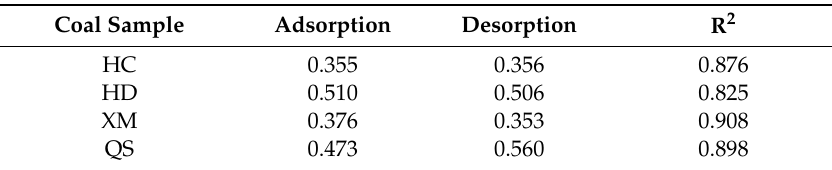
Table 6. Stretching parameter α .